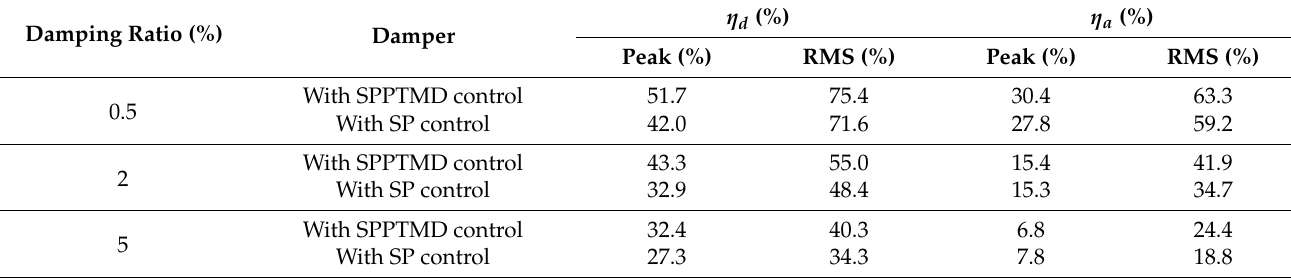
Table 3. Vibration reduction ratios of the tower with different damping